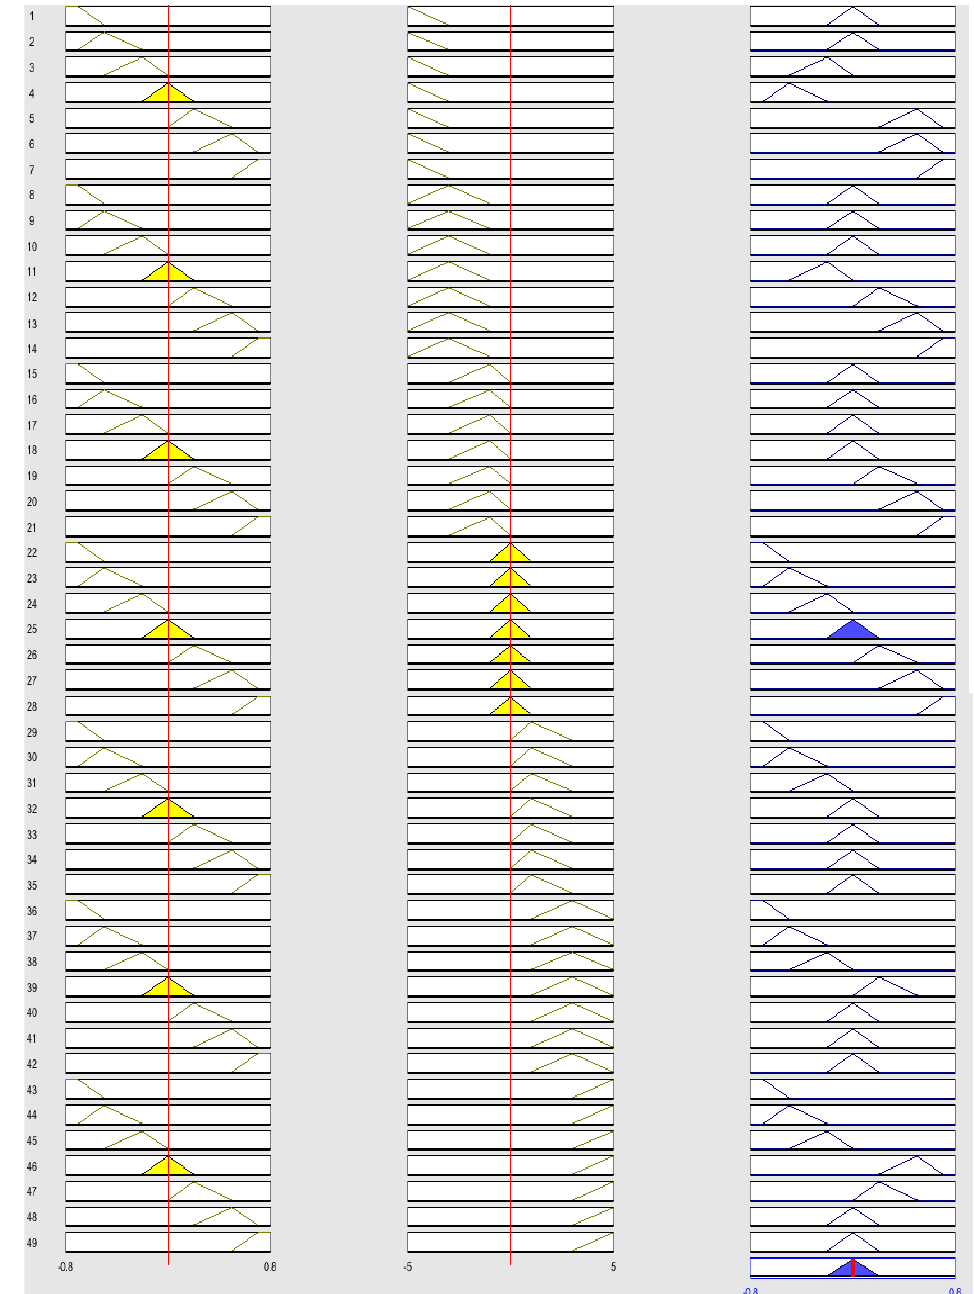
Figure 9. Amount of error and change of power and voltage based on the fuzzy controller.